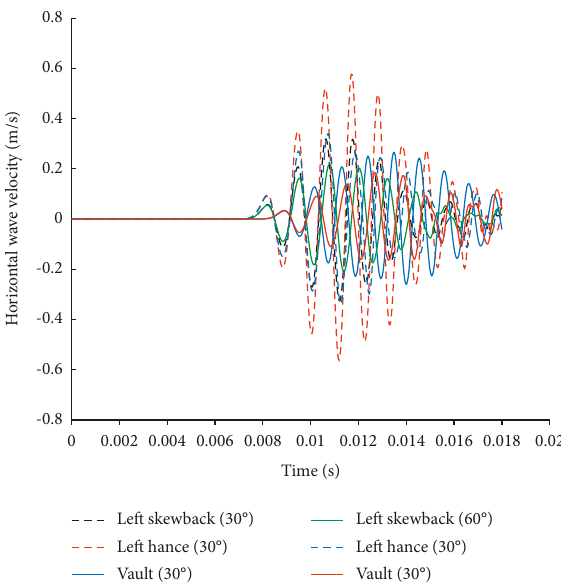
Figure 13: Horizontal wave velocity of each measuring point in tunnel when the angle of discontinuity is 30 ° and 60 ° , respectively.